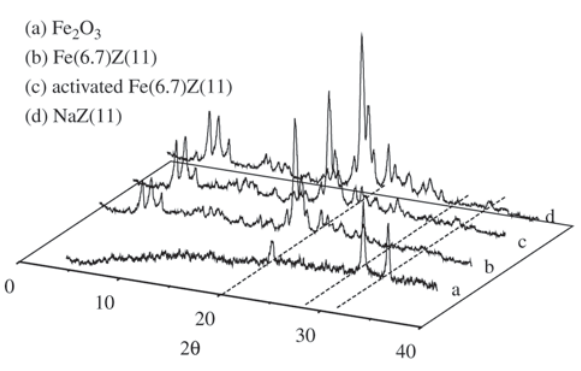
Figure 6. XRD patterns of: (a) hematite (Fe Fe/ZSM-5 catalysts prepared in aqueous medium and (d) the pre- cursor Na/ZSM-5.